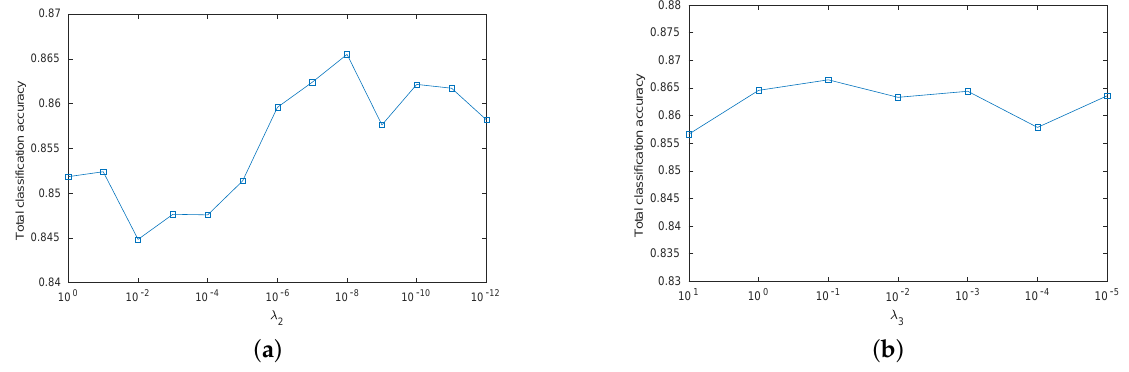
Figure 11. Eigenvalue versus varying scale parameter λ 2 , λ 3 . ( a ) λ 2 varies from 1 to 10 − 12 . ( b ) λ 3 varies from 10 to 10 − 5 .